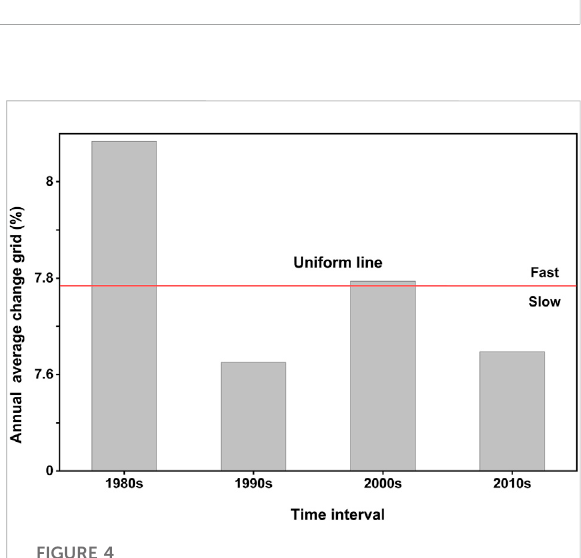
FIGURE 4 The interval intensity analysis for the 1980s, 1990s, 2000s, and 2010s.